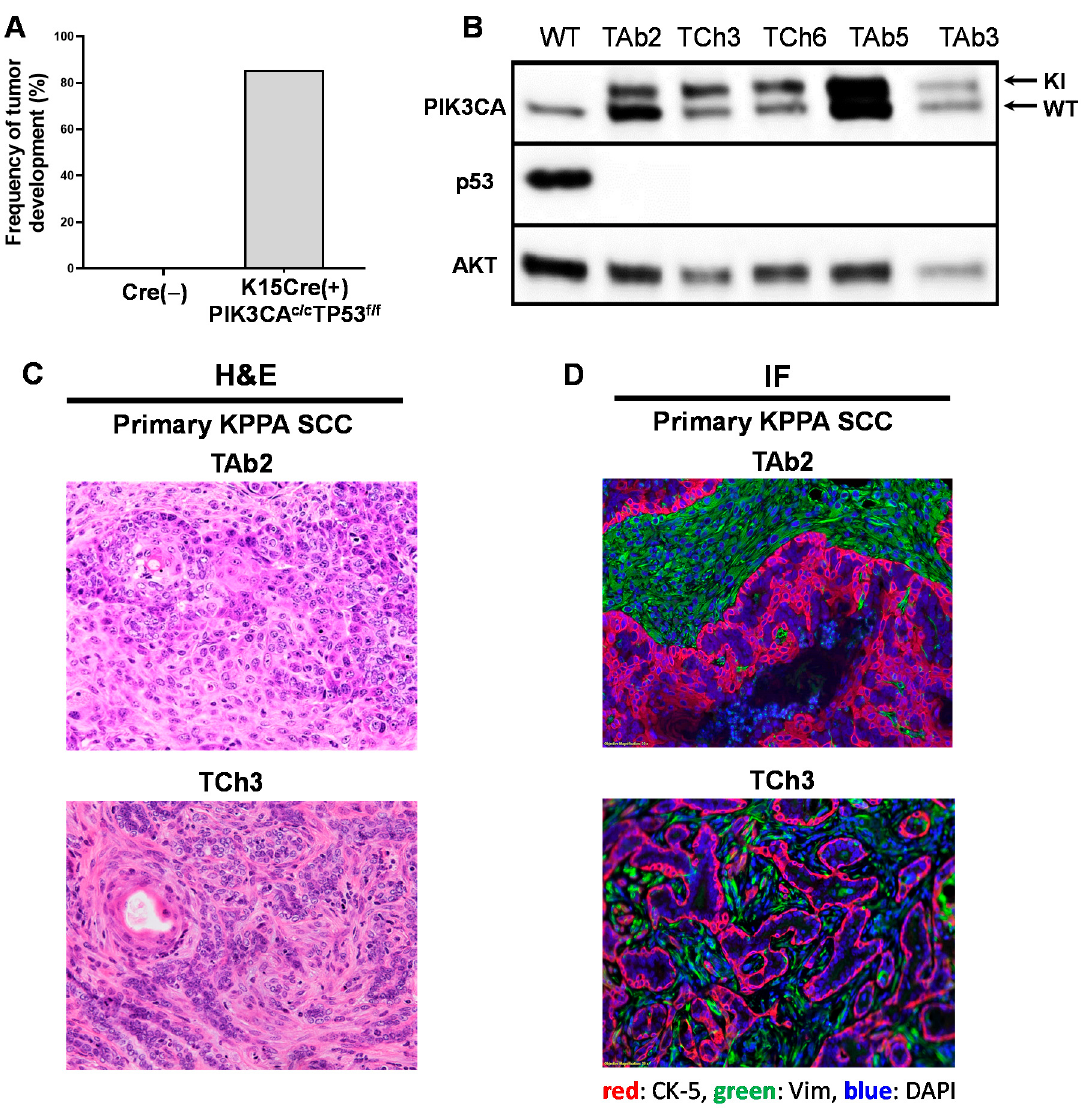
Figure 2. Establishment of Keratin-15-p53-PIK3CA (KPPA) tumor models by deleting tumor protein p53 ( TP53 ) and constitutively activating phosphatidylinositol-4,5-bisphosphate 3-kinase catalytic subunit alpha ( PIK3CA ). ( A ) Bar graph showing the frequency of tumor development. None of the littermate control mice (K15.CrePR1( − ) PIK3CA C / C / TP53 f / f ) developed tumors ( n = 10). Of the K15.CrePR1( + ) PIK3CA C / C / TP53 f / f mice, 85.7% developed tumors ( n = 14); ( B ) Western blot analysis showing the deletion of p53 and expression of constitutively active PIK3CA protein in KPPA tumors. Five independent KPPA tumors were analyzed by Western blot with wild-type (WT) B6 spleen as control. KPPA tumors expressed both endogenous (lower band) and knock-in (KI) (higher band) PIK3CA protein, and deleted p53 protein. AKT protein is the loading control; ( C ) H&E analysis of KPPA tumor morphology. Representative images of H&E staining for primary KPPA squamous cell carcinomas (SCCs) and primary KPPA pleomorphic carcinoma; ( D ) Immunofluorescence (IF) staining of KPPA tumors. Representative images of IF staining for primary KPPA SCCs and primary KPPA pleomorphic carcinoma. Cytokeratin 5 (CK-5 + ) (red) tumor cells were separated from vimentin (Vim + ) (green) stroma cells. DAPI (blue) staining indicated nuclei. Magnification: 20 × .